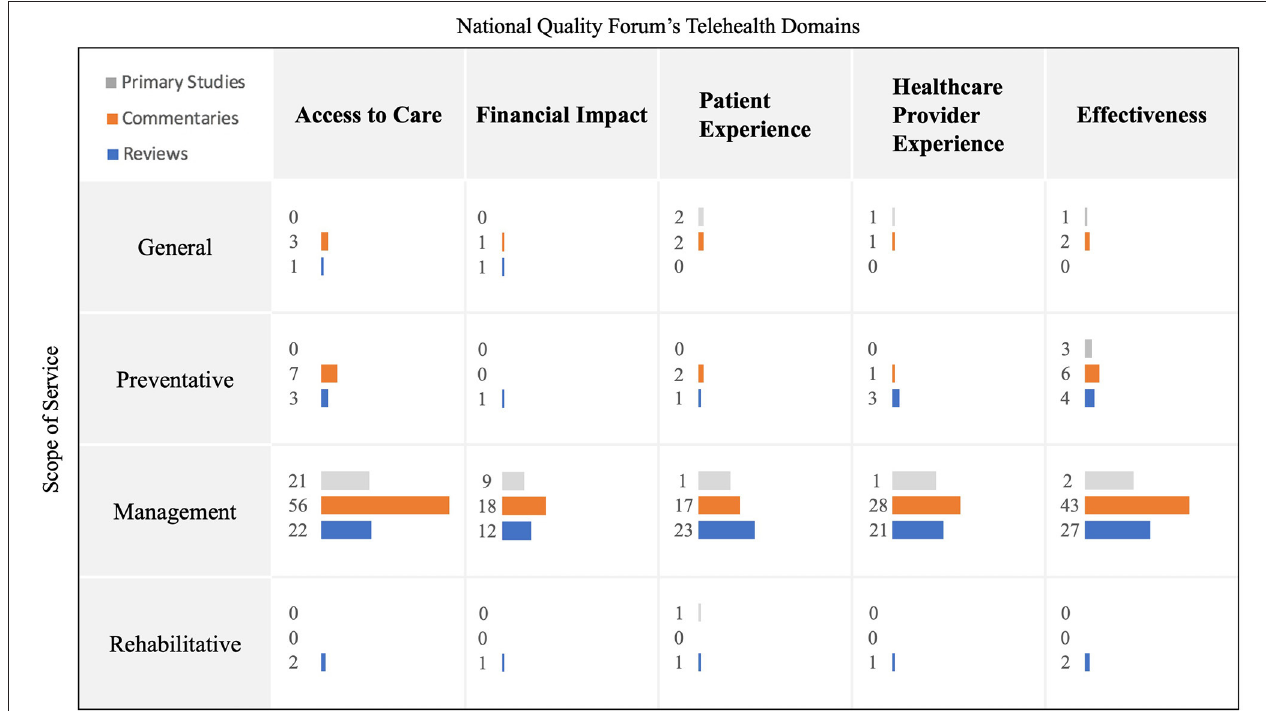
FIGURE 3 | Visual map for scope of service, NQF framework and article type. Preventative: Screening/Triage/Lifestyle/Social connectedness; Management: Treatment/Follow-up Rehabilitative: restoration of optimal level functioning in those with a mental illness; General: No definitive focus; Gray bars: Primary studies; Orange bars: Commentaries, viewpoints, editorials, perspectives; Blue bars: Literature and Scoping reviews; The length of the bars and the numbers correspond to the total number of identified